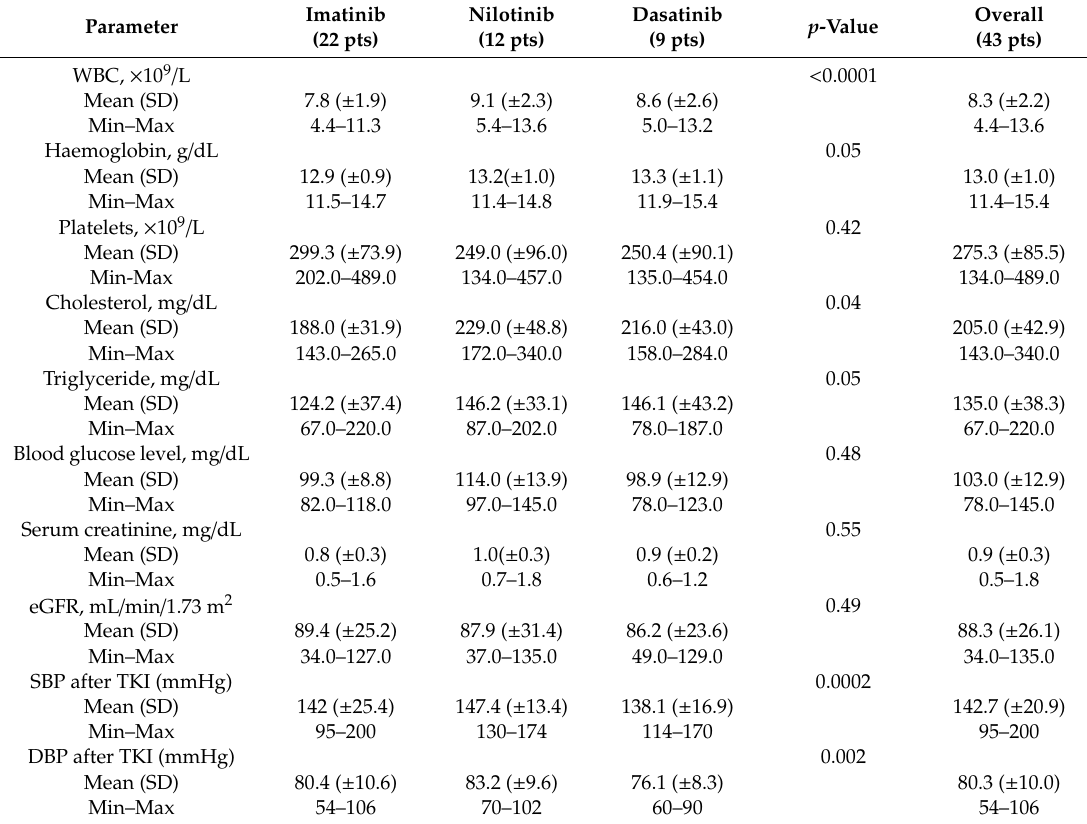
Table 5. Re-evaluation of patient